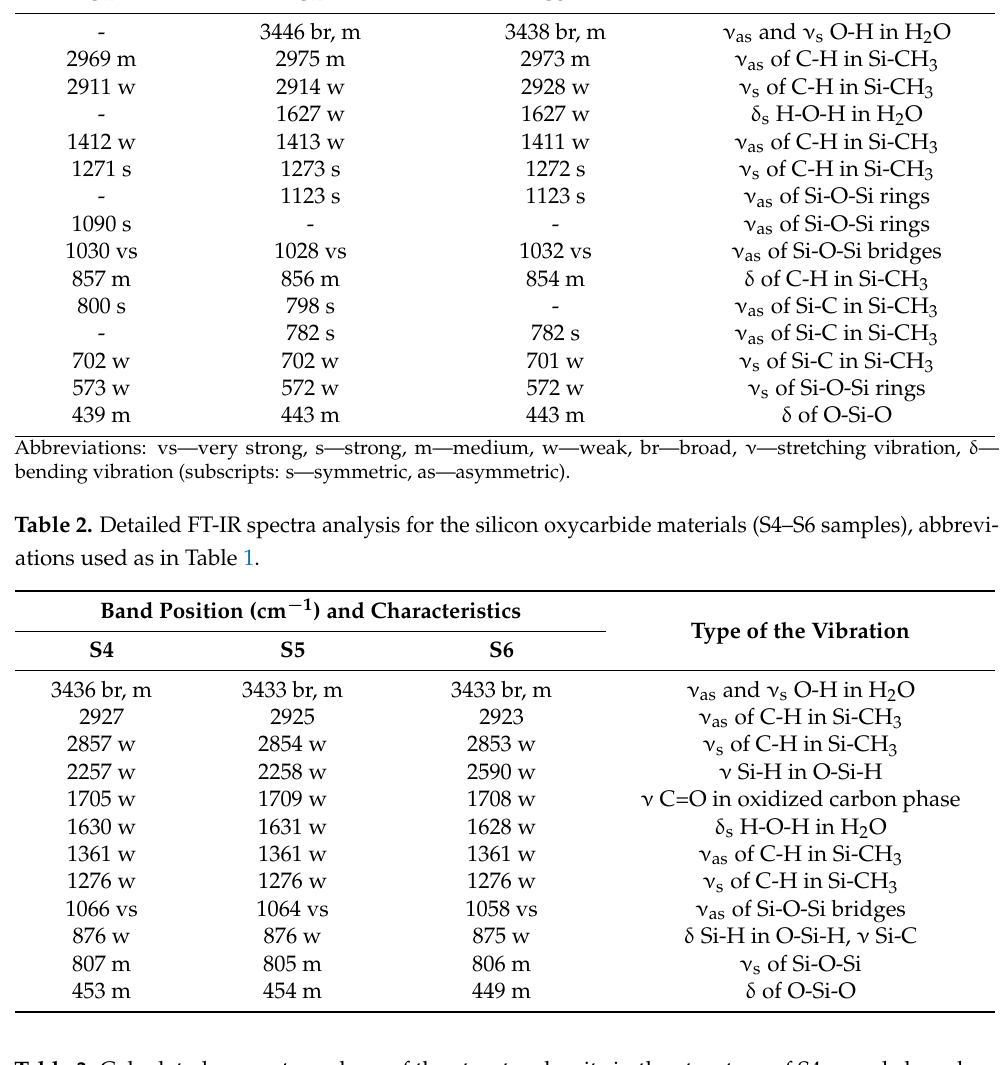
Table 3. Calculated percentage share of the structural units in the structure of S4 sample based on 29 Si MAS NMR